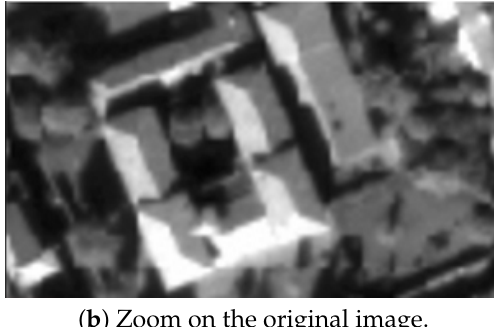
( b ) Zoom on the original image.